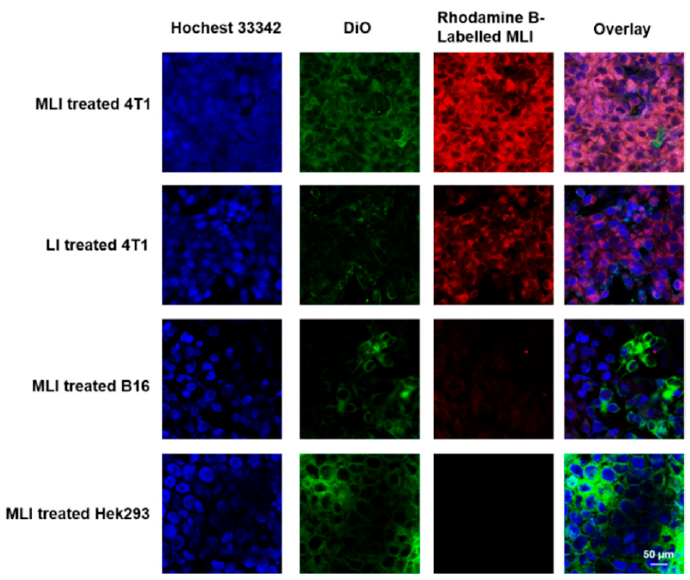
Figure 3. In vitro inspection of homologous-targeting capabilities of MLI. Intracellular co-localization of Rhodamine B-labelled MLI or LI (red) to various DiO/Hoechst 33342 dual-stained cells (green and blue) after 4 h co-incubation.